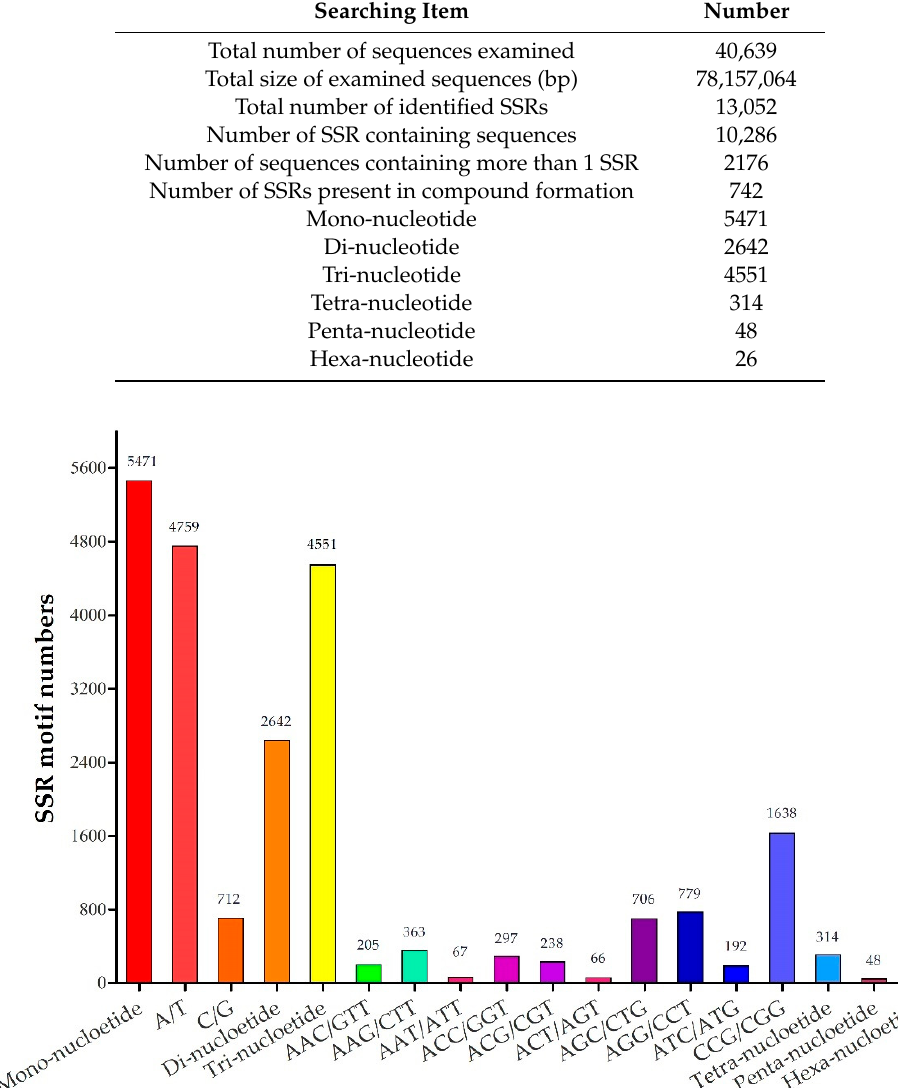
Table 1. Statistical table of SSR (simple sequence repeat) analysis results.